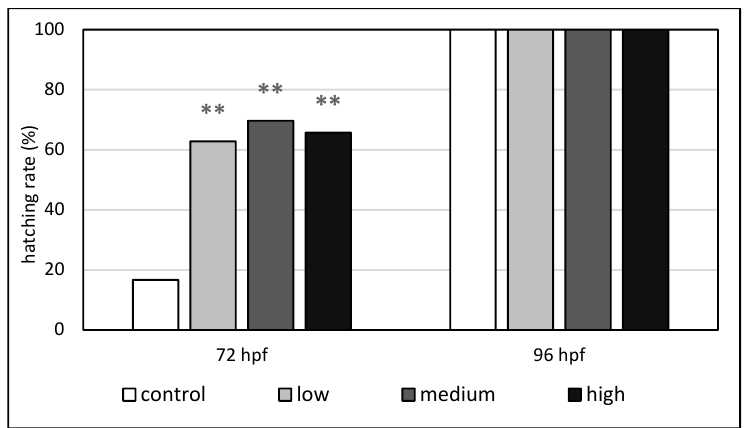
Figure 2. The hatching rate (%) of zebrafish exposed to citalopram hydrochloride (hpf—hours post- fertilization). The asterisk indicates a significant difference (** p < 0.01) between the control and the experimental groups at the same time of exposure.